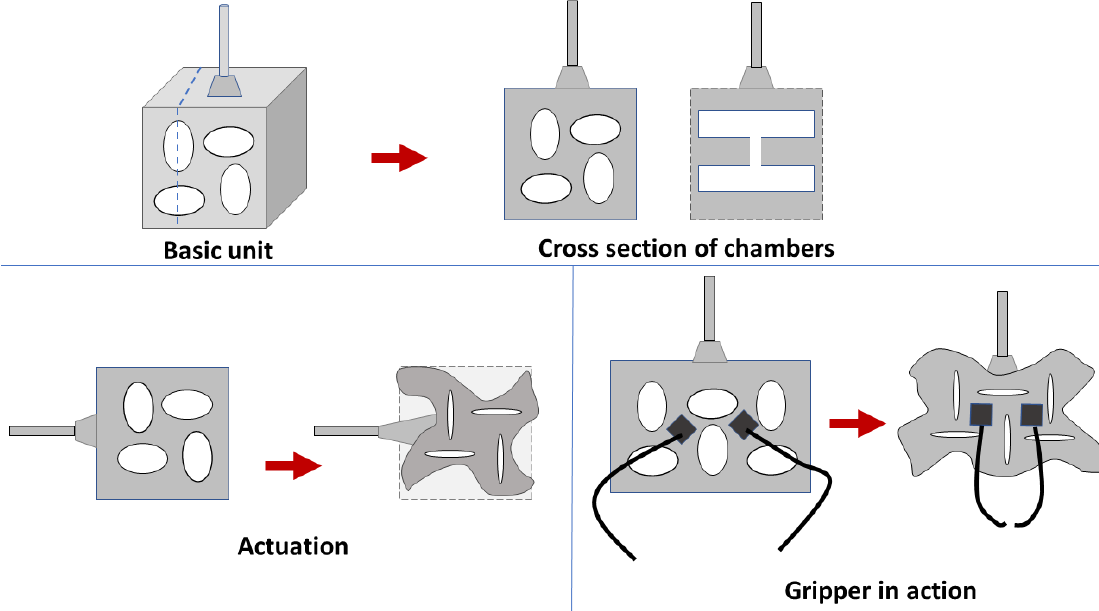
Figure 4. Vacuum-operated buckling FEA actuators, based on [51].